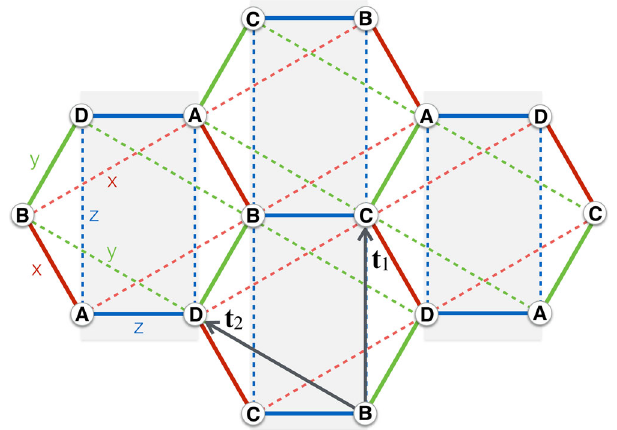
FIG. 1. The Kitaev K 1 − K 2 model with three types of NN (solid) and NNN (dashed) Ising bonds. Here, t 1 ¼ a y and t 2 ¼ ffiffiffi p ½ − ð 3 = 2 Þ x þ ð 1 = 2 Þ y (cid:2) a are two primitive translations and a is a lattice constant. We also show the vertical 2-leg ladders (shaded strips) discussed in the text, and the four-sublattice decomposi- tion (A – D) related to the operations H